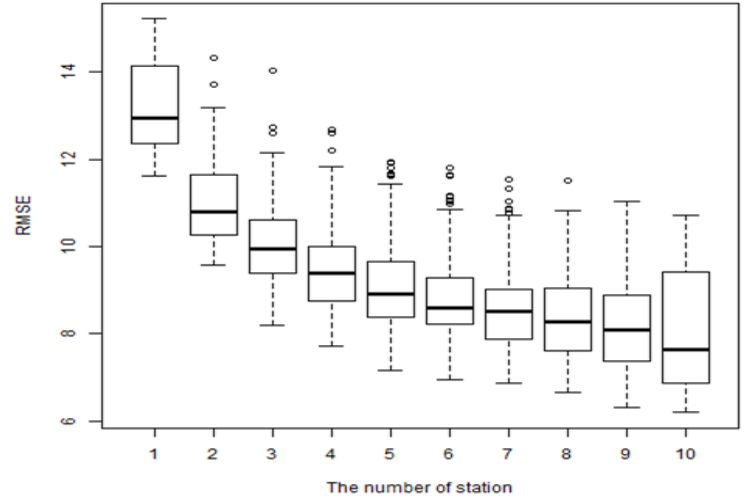
Figure 4. The performances of all combination gauge networks.